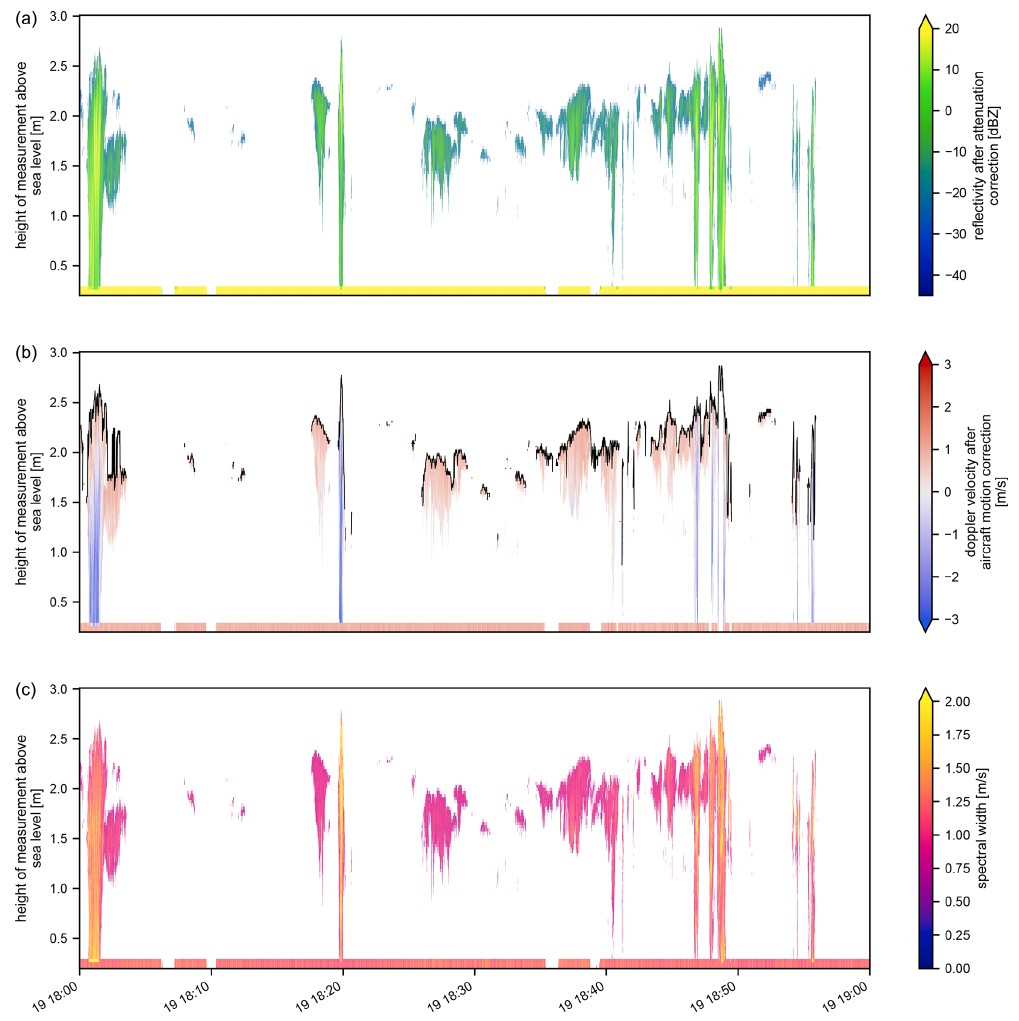
Figure 6. One example hour (18:00–19:00UTC on 19 January 2020) of observations made by the W-band radar during ATOMIC. Panel (a) shows attenuation-corrected radar reflectivity (dBZ); panel (b) shows the Doppler velocity after correction for aircraft motion (ms − 1 ); panel (c) shows the the width of the Doppler spectrum (ms − 1 ). Observations with radar signal-to-noise ratio of less than − 10dB have been removed for clarity. Clouds observed during this hour were relatively deep, frequently reaching 2.5–3km, with frequent periods of rain visible in the high-reflectivity, negative Doppler velocity (drops moving away from the aircraft, i.e., falling, in blue), and enhanced spectral width extending from near cloud top to the surface. During ATOMIC, clouds without precipitation typically have reflectivity less than − 25dBZ; in this figure small precipitation drops (green colors in the reflectivity panel) are embedded in the clouds most of the time. The radar has sufficient sensitivity to see these weak returns out to about 2km below the aircraft (about 1km altitude). Doppler width is broadened by the aircraft flight speed, which adds a threshold of about 0.5ms − 1